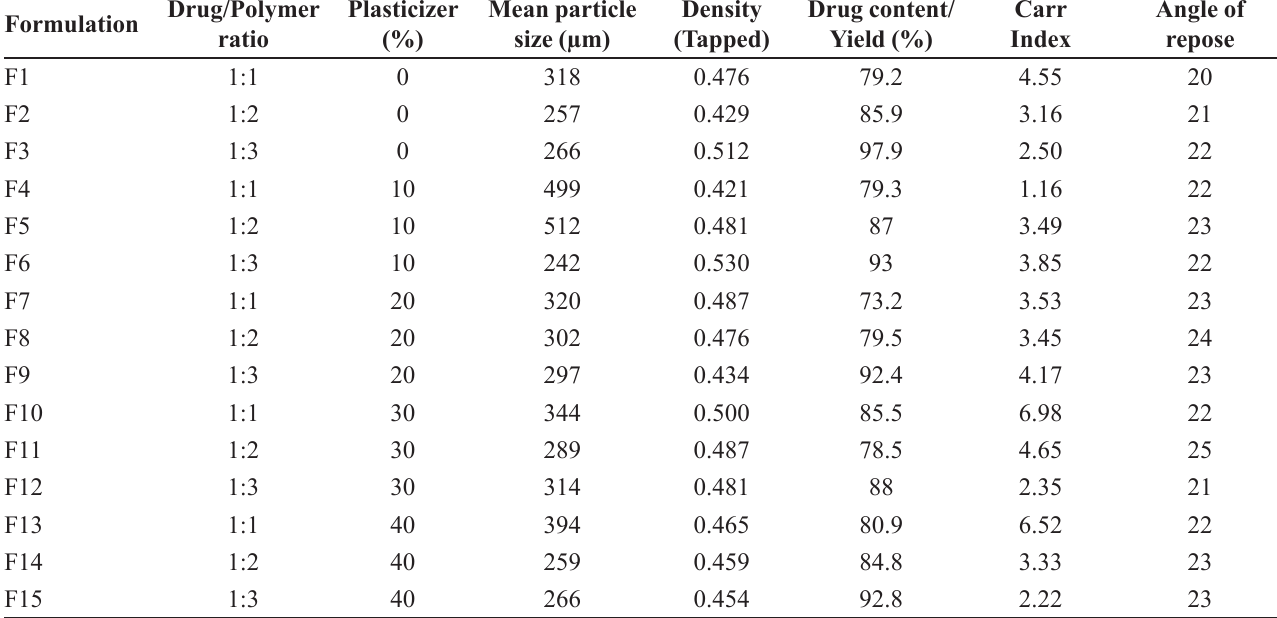
TABLE II - Physical properties of theophylline microcapsule formulations